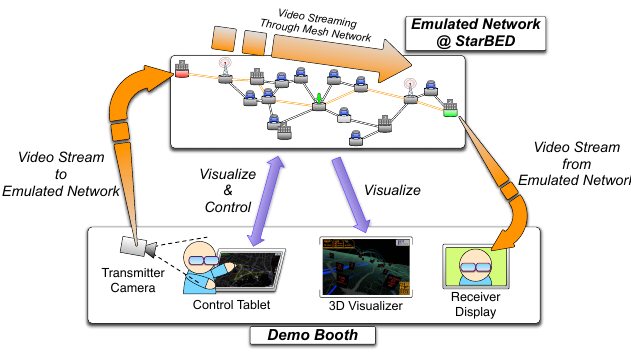
Figure 3: The 3D visualizer.